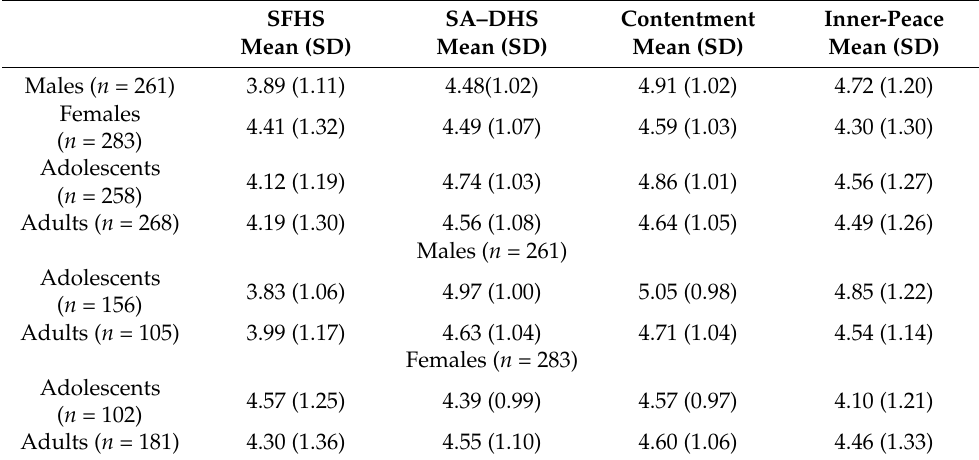
Table 1. Means and standard deviations for all the scores of the scales in sex and age